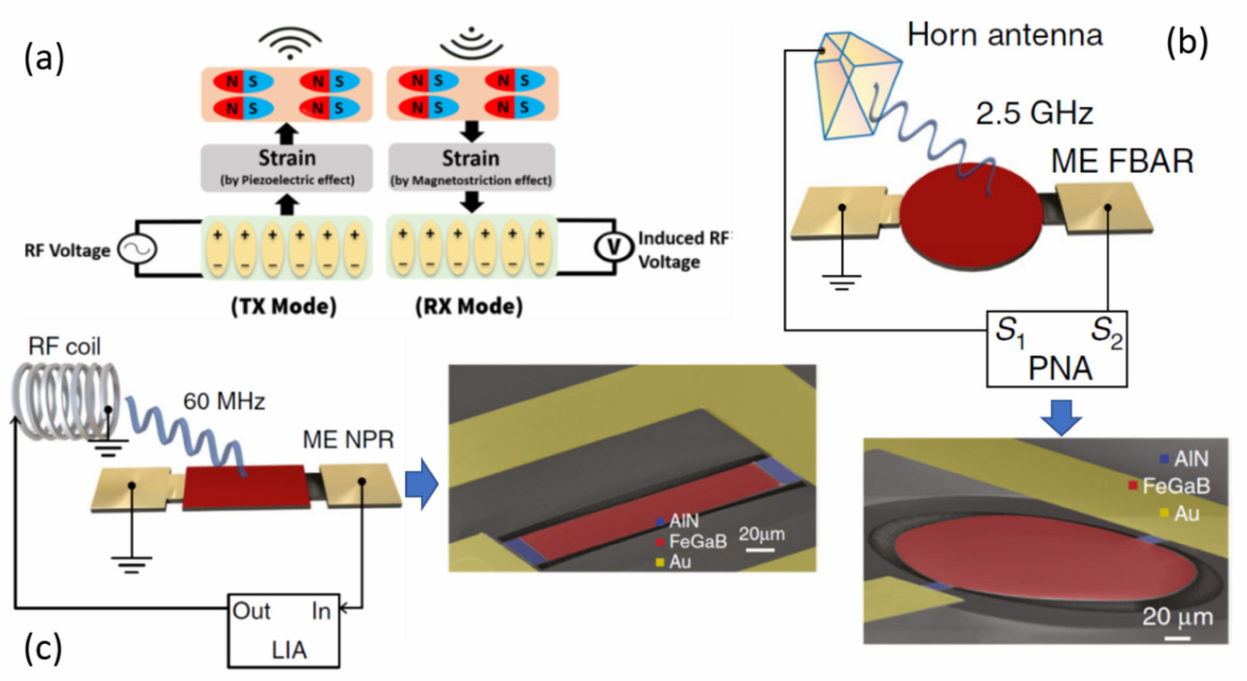
Figure 10. ( a ) Schematic conceptualizing transmitter ( T x ) and receiver ( R x ) modes in ME antenna. ( b ) Schematic of the ME thin-film FBAR with the antenna measurement setup where horn antenna and ME FBAR are connected to the network analyzer consisting of S 1 and S 2 ports. The bottom figure shows the SEM image of the ME FBAR. ( c ) Schematic of the ME NPR and the ME measurement setup using a high-frequency lock-in amplifier (HFLIA). The side figure shows the SEM image of the ME NPR. Reprinted with permission from ref. [46,47]. Copyright 2021 Springer Nature